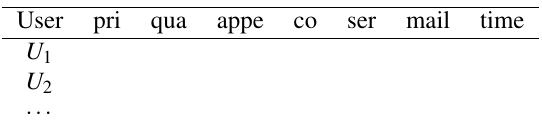
Table 1. User Evaluation Data